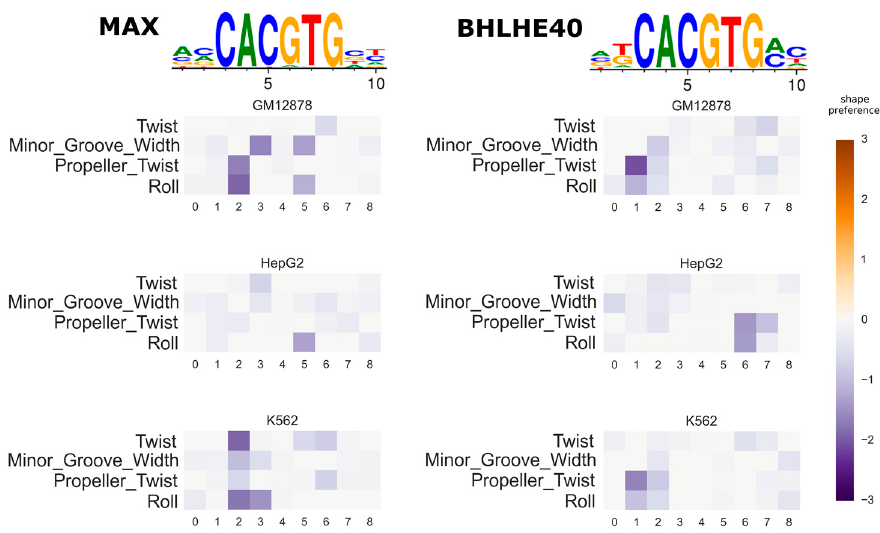
Figure 4. Predicted shape preferences of MYC Associated Factor X (MAX) and Basic Helix-Loop-Helix Family Member E40 (BHLHE40) in three cell lines. The heatmaps show the preference for each shape feature at each position (the inferred d f matrix). Only the negative preferences are shown here, that is the preferences towards lower values of shape features. Colors faded to grey mean weaker preference. The PWM logos are shown above the shape preference heatmaps.